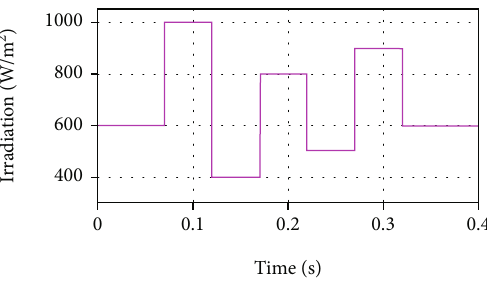
Figure 11: Rapid variation of solar irradiation pro fi